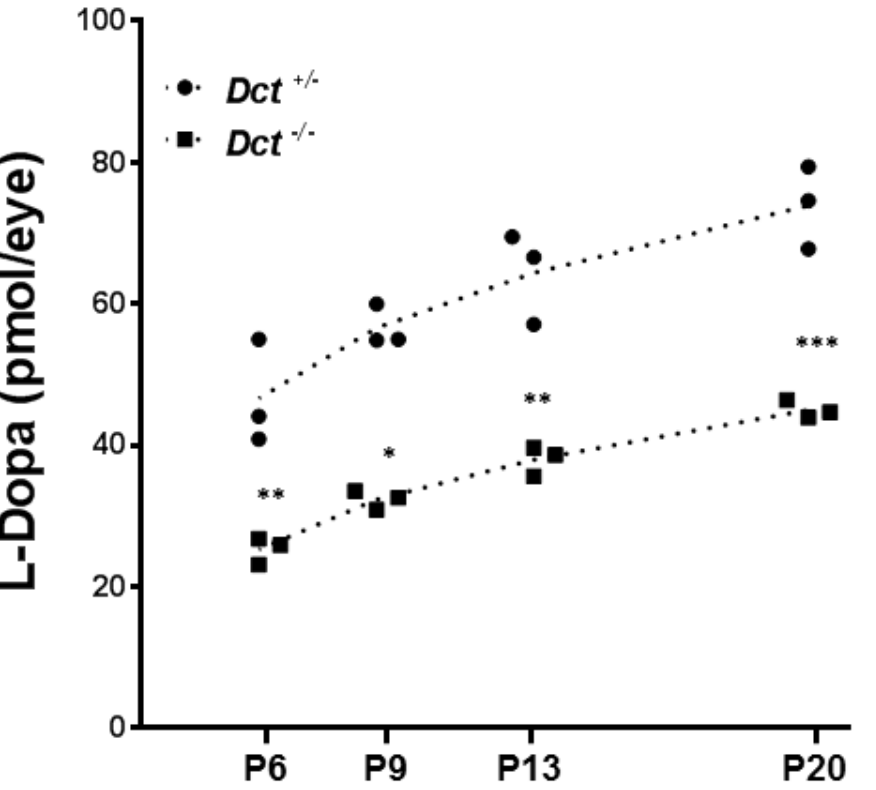
Figure 6. Dosage of L-Dopa in postnatal eyecups. L-Dopa was quantified by HPIC in Dct − / − eyecups (square symbols)) compared to Dct +/ − (black dots). Eyecups from Tyr c/c mice were used to define the baseline. At each indicated postnatal day: P6, P9, P13, P20, both eyes from 3 littermates of each genotype were dissected, pooled, and used for dosage. For each stage of development, L-Dopa quantification for both genotypes were compared by using unpaired t -test,* p < 0.05, ** p < 0.01; *** p < 0.001. As expected, L-Dopa was not detected in samples from Tyr c/c control mice (not shown). By contrast, L-Dopa was detected in substantial amounts in Dct − / − eyecups, and